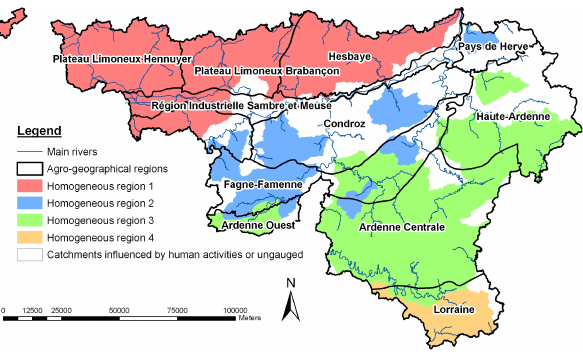
Table 4. Regression coefficients of the model for re-